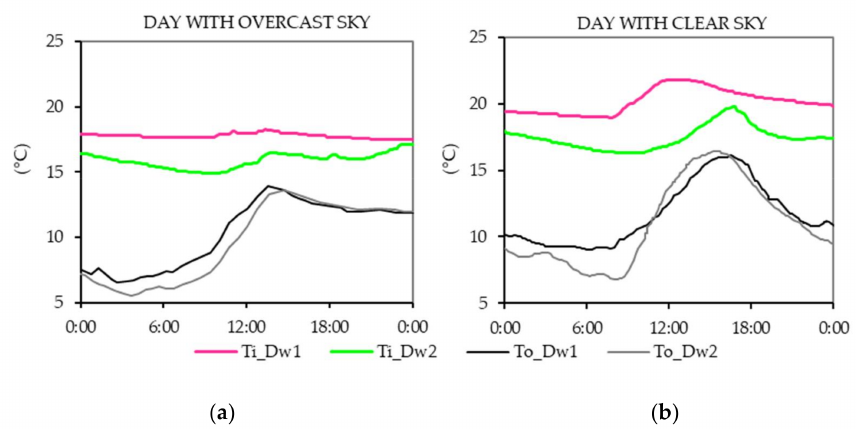
Figure 7. Dw1 and Dw2 outdoor and indoor temperatures, ( a ) in overcast day, and ( b ) clear sky day.